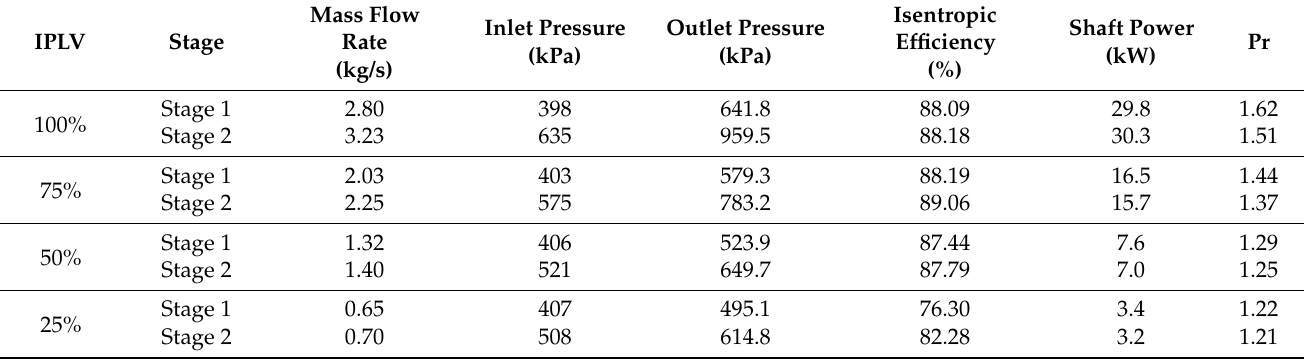
Table 9. Numerical simulation results for R-513A refrigerant two-stage centrifugal compressor loads.